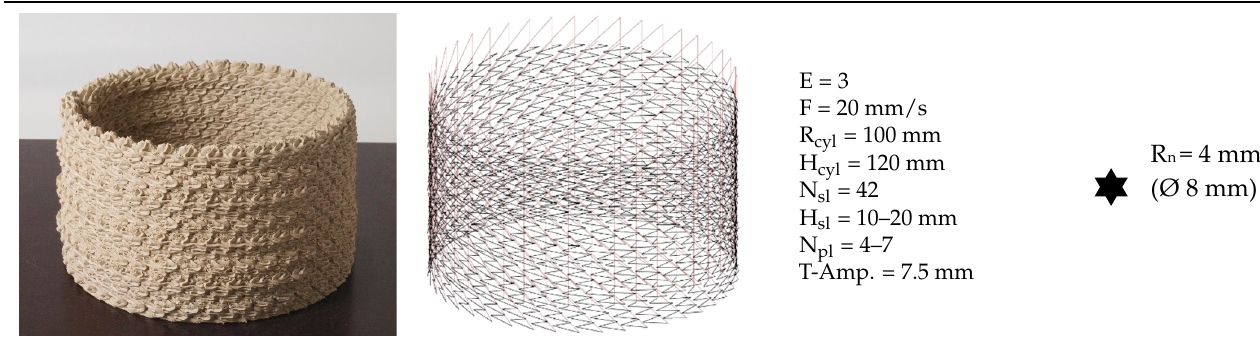
Table 2. Comparison of Grasshopper modelling as complex path instruction and materialized implementation with star-shaped material outlet in the LDM of clay.